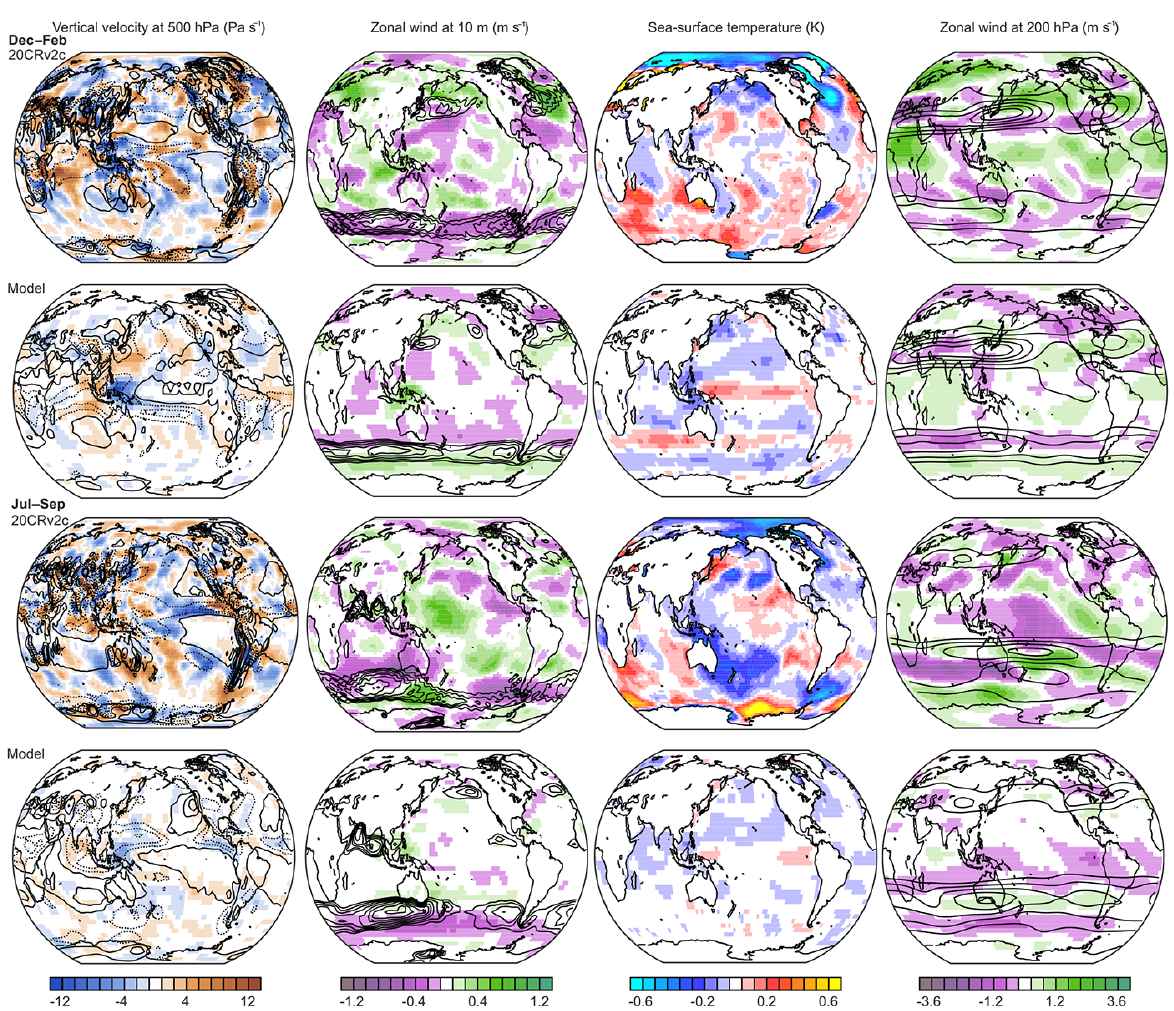
Figure 6. Composite fields for easterly minus westerly QBO phases at 70hPa for (left) 500hPa vertical velocity (shading, contours indicate climatology, spacing is 40Pas − 1 symmetric around zero, dashed lines are negative), 10m zonal wind (shading, contours indicate climatology from 4ms − 1 in steps of 1ms − 1 ), SST and 200hPa zonal wind (shading, contours indicate climatology from 20ms − 1 in steps of 10ms − 1 ) for boreal summer and winter in 20CRv2c and in the model simulations. See Fig. S12 for